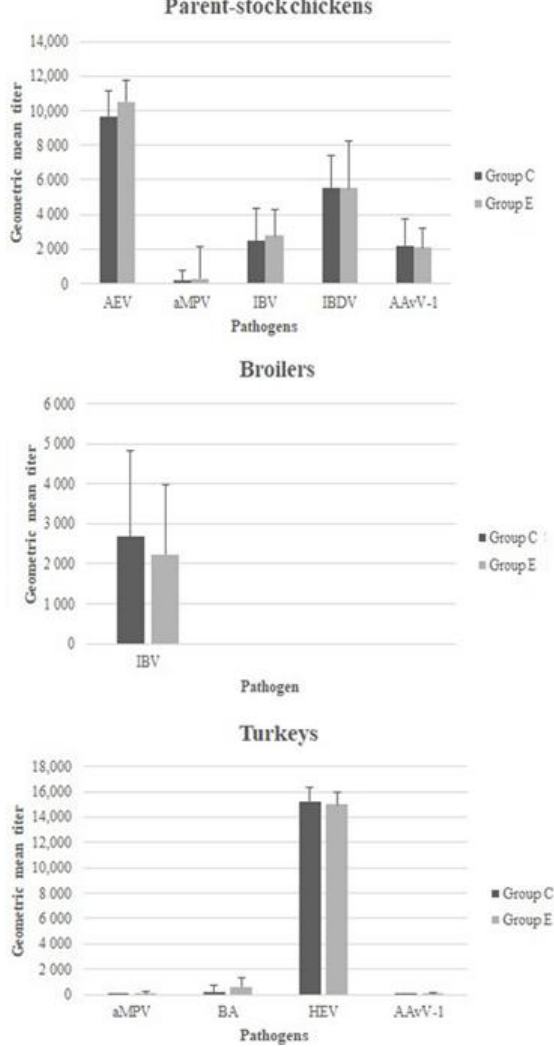
Figure 1. Mean specific-IgY (AEV—Avian encephalomyelitis virus, aMPV—Avian metapneumovirus, BA—Bordetella avium, HEV—Hemorrhagic Enteritis Virus, IBDV—Infectious Bursal Disease Virus, IBV—Infectious Bronchitis virus, AAvV-1—Newcastle Disease Virus) geometric titers in serum samples in two groups (C—control, E—experimental) of parent-stock chickens, broiler chickens, and turkeys.